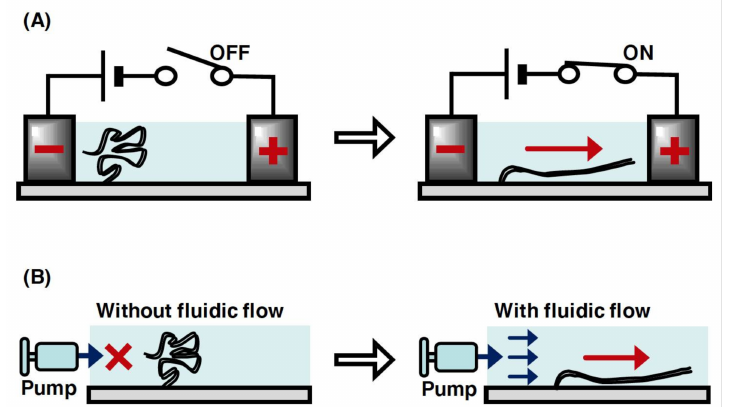
Figure 5. Conceptual diagram of the manipulation of single DNA molecules with one end immobi- lized on a surface. ( A ) Stretching manipulation of single DNA molecules by a DC electric field. The DNA molecule is relaxed without the application of electric field but stretched with the application of it. ( B ) Stretching of single DNA molecule by the fluid flow. The DNA molecule is relaxed without the fluid flow but stretched with the fluid